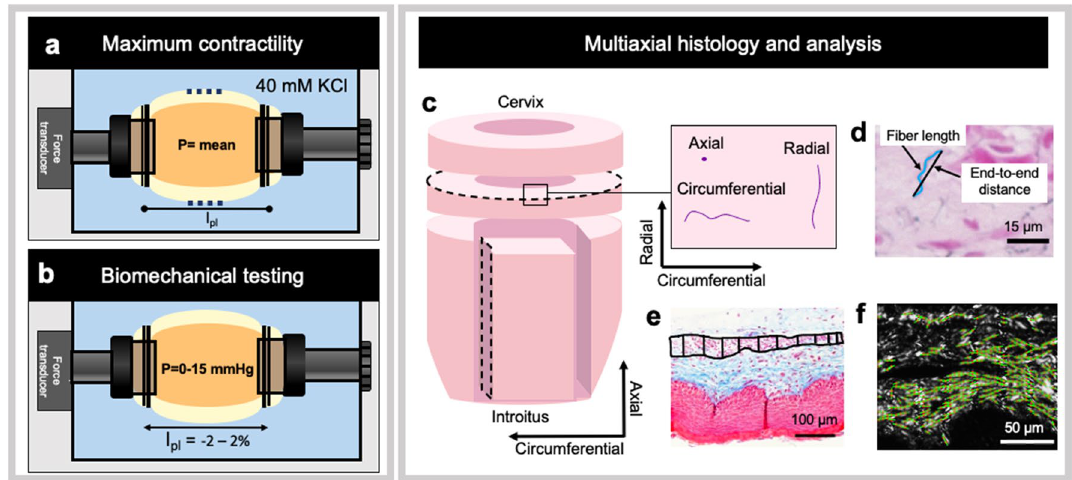
Figure 2. Schematic of experimental design. Schematic of extension-inflation device ( a , b ). A video- microscope (dashed lines) optically tracked the outer diameter and a force transducer measured axial force. At the physiologic length (l pl ) and mean in vivo pressure (P) 40 mM of potassium chloride (KCl) induced maximum SMC contraction ( a ). For passive biaxial biomechanical testing, the vagina was subjected to increasing vaginal pressures at various fixed axial lengths ( c ). Circumferential and axial sections randomly taken from the proximal or distal region of the vagina (not depicted) permitted multiaxial histological analysis ( c ). When analyzing the circumferential plane fibers oriented towards the circumferential and radial directions. Fibers in the axial direction were perpendicular to the circumferential plane and appeared as small dots ( d ). Representative zoomed in Hart’s elastin image measuring the fiber length and end-to-end distance to quantify elastic fiber tortuosity ( d ). ImageJ quantified muscularis thickness using the Masson’s trichrome stained images ( e ). Representative zoomed in Picrosirius red image showing the extracted fiber features using the CurveAlign open-source software for bulk assessment to quantify collagen fiber alignment ( f from the cervovaginal complex in 4 °C Hank’s Balanced Salt Solution 31 . Two 6–0 sutures mounted the Fbln5 + / + , Fbln5 +/− , and Fbln5 −/− with grade 1 POP vaginas onto 3.75 mm-diameter cannulas in the pressure-myograph system (Danish Myo Technology, Aarhus, Denmark). Due to the vaginas from the Fbln5 −/− with grade 2 or 3 POP being larger in diameter 5.00 mm-diameter cannulas were used for this group. The vagina was submerged in Krebs Ringer Buffer (KRB; 120 mM NaCl, 25 mM NaHCO 3 , 4.7 mM KCl, 2.5 mM CaCl 2 , 1.2 mM NaH 2 PO 4 , 1.2 mM MgCl 2 , 11 mM glucose) at 37 °C aerated with 95% O 2 and 5% CO 2 to maintain pH at 7.4 17,46 . Identification of the vaginal unloaded length and outer diameter occurred where the organ slightly buckled and did not collapse, respectively, as illustrated previously by Robison et al. 31 . Explanting the vagina and removing the natural tethering, such as the paravaginal fascia, resulted in the vagina retracting (i.e., shortening in length). Therefore, the linear stage axially extended the vagina to the physiologic length 34 . Measuring the in vivo to ex vivo change in vaginal axial length between stain lines placed during dissection initially estimated retraction of the vagina 31,34,45 . Upon identifying the unloaded configuration within the device, a digital caliper (Mitutoyo, #CD-6”-ASX, Kawasaki, Kanagawa, Japan) measured the suture to suture length. The force transducer further evaluated the physiologic length wherein the transducer-measured axial force held constant over a range of increasing pressure from 0 to 15 mmHg preserving energy as previously described 31,33,47 . An integrated system of components (Eclipse TS100 Microscope, Nikon, Melville, NY, USA) and software (Myoview Software, Danish Myo Technology, Aarhus, Denmark) recorded the outer diameter and transducer-measured axial force during mechanical testing. The linear micrometer returned the vagina to its unloaded length to pre-expose the smooth muscle cells to potassium-chloride (KCl) for contraction. The SMCs were first preconditioned under low loads about the in vivo pressure to ensure viability. Intralumi- nal pressure was set to one standard deviation below the mean measured in vivo pressure ( Fbln5 + / + = 5 mmHg, Fbln5 +/− = 4 mmHg, and Fbln5 −/− grade 1 and 2/3 POP = 7 mmHg) 17,18,48 . The linear stage axially extended the vagina from the unloaded length to the length wherein the transducer-measured force equalled zero. The SMCs were stimulated with 40 mM of KCl for 5 min to achieve a steady maximum contractile response 18,49 . Fresh KRB washed the vagina and returned SMC tone to the basal state. KCl induces muscle contraction through direct membrane depolarization of the SMC by opening voltage dependent calcium channels resulting in an influx of extracellular calcium. This simple mechanism of contraction served as initial interest because it induces a tonic contractile response and is independent of neural function and the number or receptor available 18,49,50 . This was then repeated at an intraluminal pressure one standard deviation above the mean measured in vivo pressure ( Fbln5 + / + = 9 mmHg, Fbln5 +/− = 6 mmHg, and Fbln5 −/− grade 1 and 2/3 POP = 11 mmHg). Five cycles of pres- surization (0–15 mmHg; 1.5 mmHg) at the physiologic length preconditioned the vagina to obtain a consistent and repeatable biomechanical response. Five cycles of axial extension (10 µm/s) from 2% below to 2% above the physiologic length at 5 mmHg (1/3 maximum pressure) further preconditioned the vagina 12,18,31,34 . The vagina equilibrated at the physiologic length and 5 mmHg (1/3 maximum pressure) for 10 mins 31 . The linear stage re- established the unloaded length and the video-camera recorded the outer diameter 18,31 .